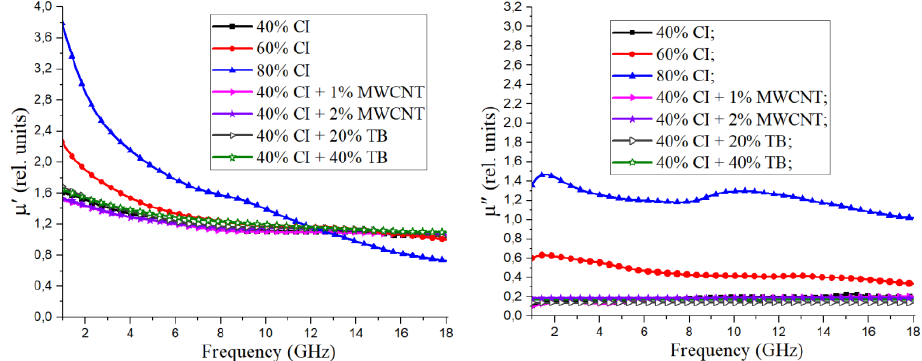
Fig. 5. Frequency dependence of the complex magnetic permeability of magnetic composites.